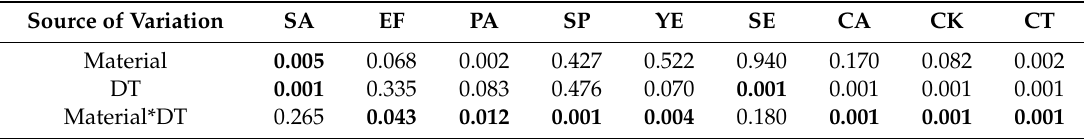
Table 7. ANOVA p -values ( p ) that show the significance of the main and interaction e ff ects of Material and distillation time (DT) on 9 antimicrobial activities. Significant e ff ects that require multiple means comparison are shown in bold.